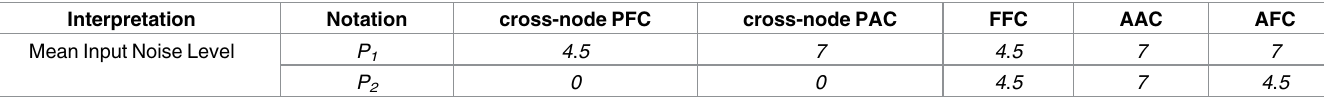
Table 2. P parameters for each CFC